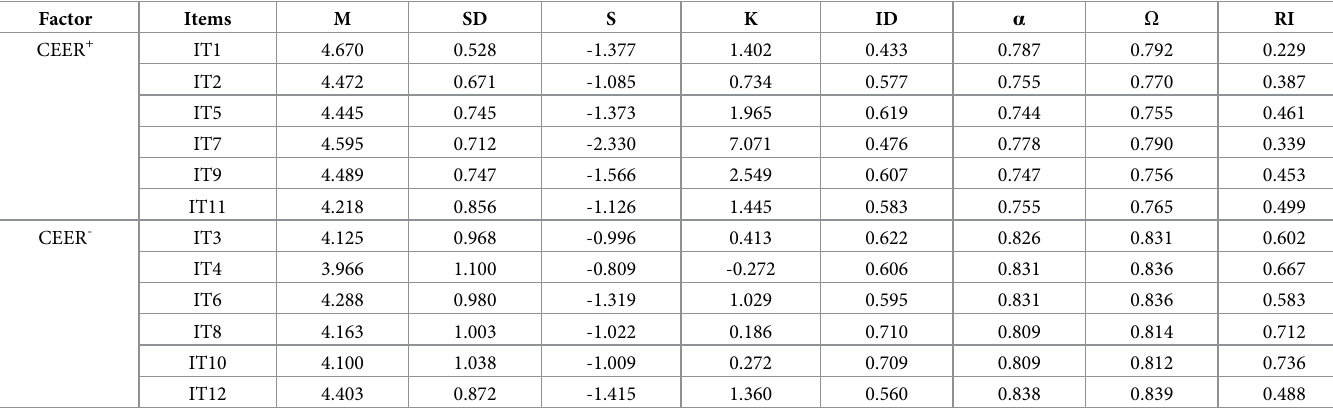
Table 3. Item descriptive statistics and metric indexes by factor in the CEER questionnaire.